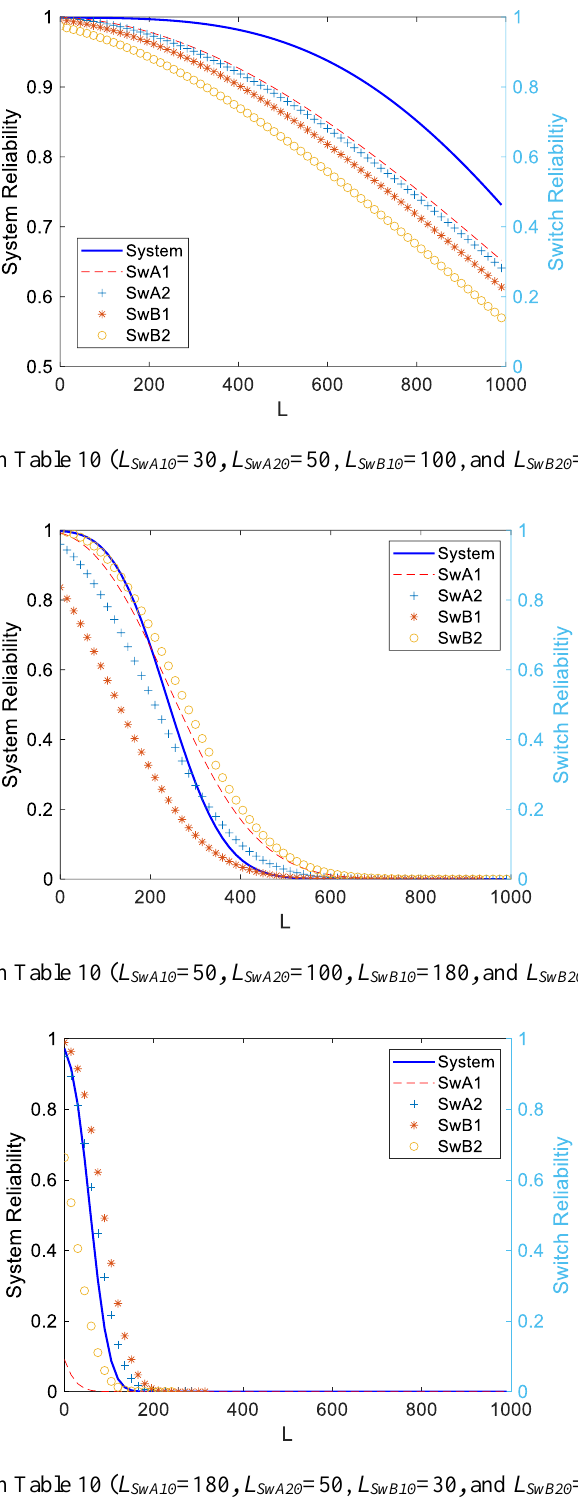
Figure 14. Set 3 in Table 10 ( L SwA10 = 180 , L SwA20 = 50, L SwB10 = 30 , and L SwB20 = 100 and α=